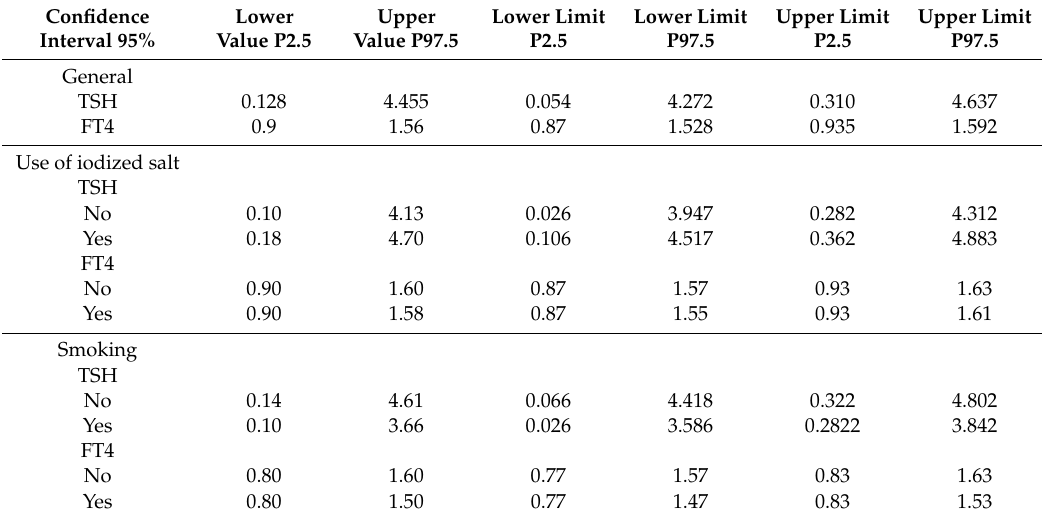
Table 4. Reference interval TSH and FT4 (non-parametric